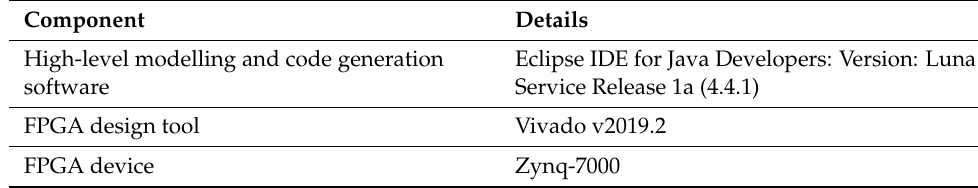
Table A3. A list of used software and hardware